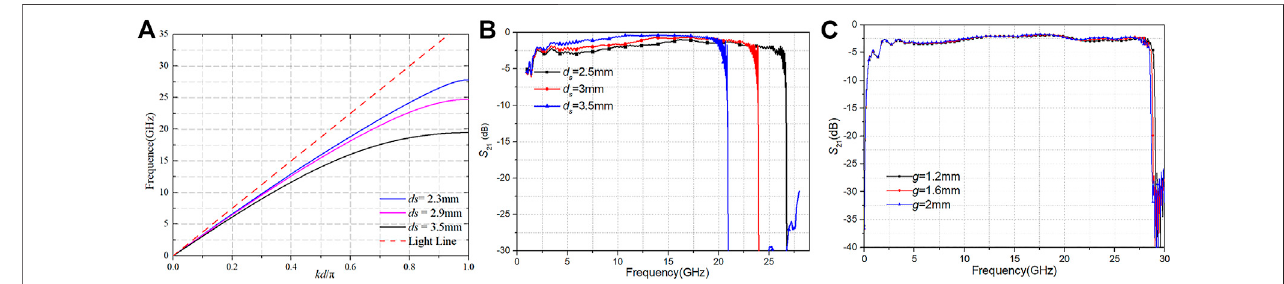
FIGURE 8 | (A) Dispersion performance of the SSPP-TL with different d s . (B) S 21 of the SSPP-TL with different d s . (C) S 21 of the SSPP-TL with different g.